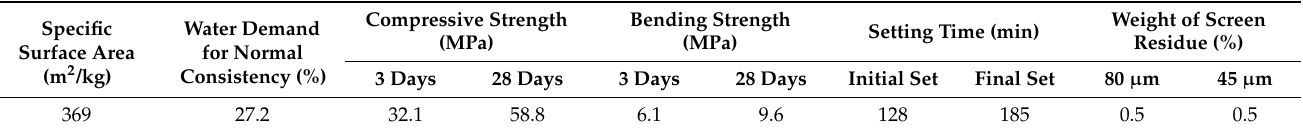
Table 2. The physico-chemistry performances of the P.I 52.5 portland cement.